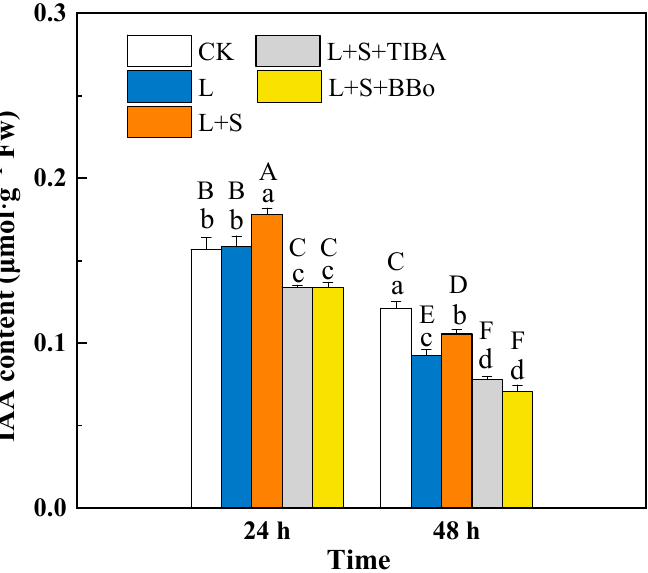
Figure 1. Effects of exogenous sucrose and IAA inhibitors on endogenous IAA content of M. baccata under sub-low temperature. Bars indicate means ± standard error ( n = 3). The lowercase letters represent significant differences between treatments ( p < 0.05). The capital letters represent significant differences between full data ( p < 0.05). The comparison of means is based on the Duncan’s multiple range test. CK, control treatment; L, sub-low root-zone temperature (5 °C); L + S, 5 °C + 90 mmol·L − 1 sucrose; L + S + TIBA, 5 °C + 90 mmol·L − 1 sucrose + 500 μ mol·L − 1 2,3,5-triiodobenzoic acid; L + S +